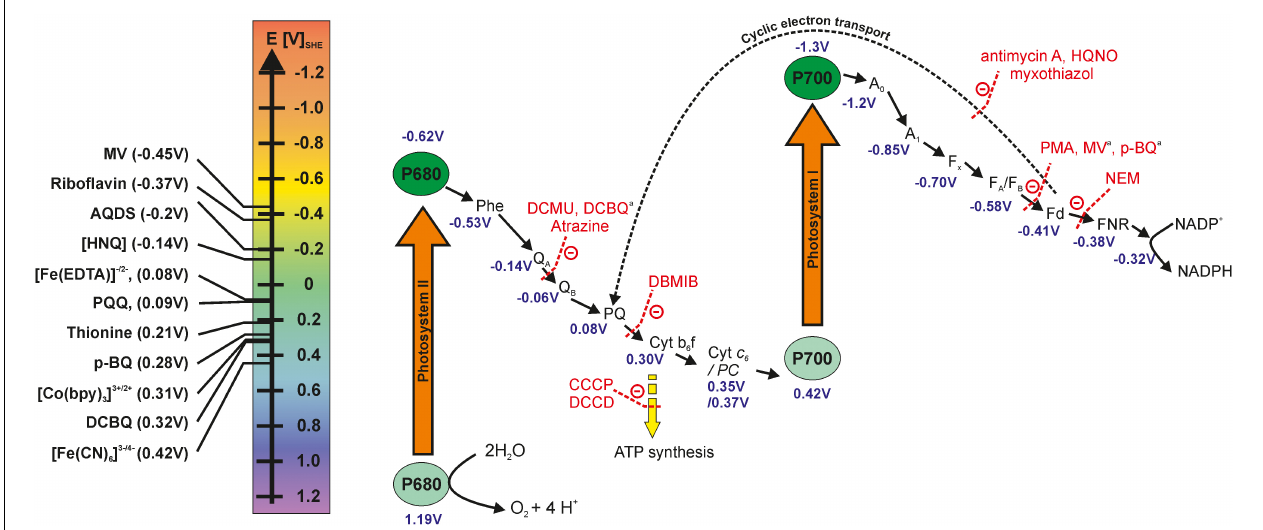
FIGURE 1 | Z-scheme of the photosynthetic electron transport chain, the electron transfer inhibitors at specific sites and potential mediator molecules that could be used for withdrawing electrons. The redox potentials of photosystem I and II subunits are diverse in the literature and the values reported here are obtained from the following sources (Bottin and Lagoutte, 1992; Semenov et al., 2000; Cassan et al., 2005; Allakhverdiev et al., 2010, 2011; Kothe et al., 2013; Caffarri et al., 2014; Schuurmans et al., 2014). The redox potentials of mediators are taken for neutral aqueous conditions from Nivinskas et al. (2002),Schuurmans et al. (2014), Lai et